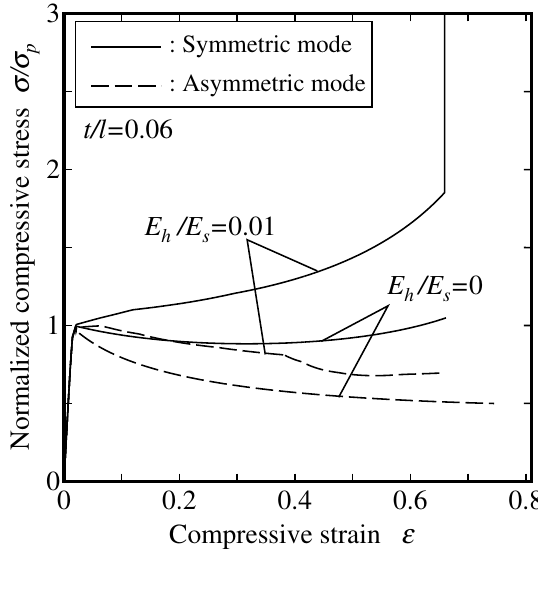
Figure 21. Stress-strain responses for an infinite honeycomb with t/l = 0 . 06